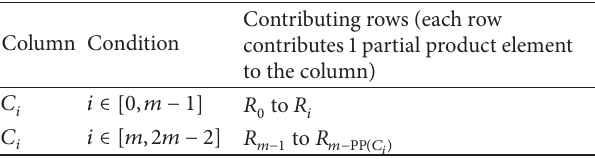
Table 4: Contributing rows for different columns for 𝑚 ∗ 𝑚